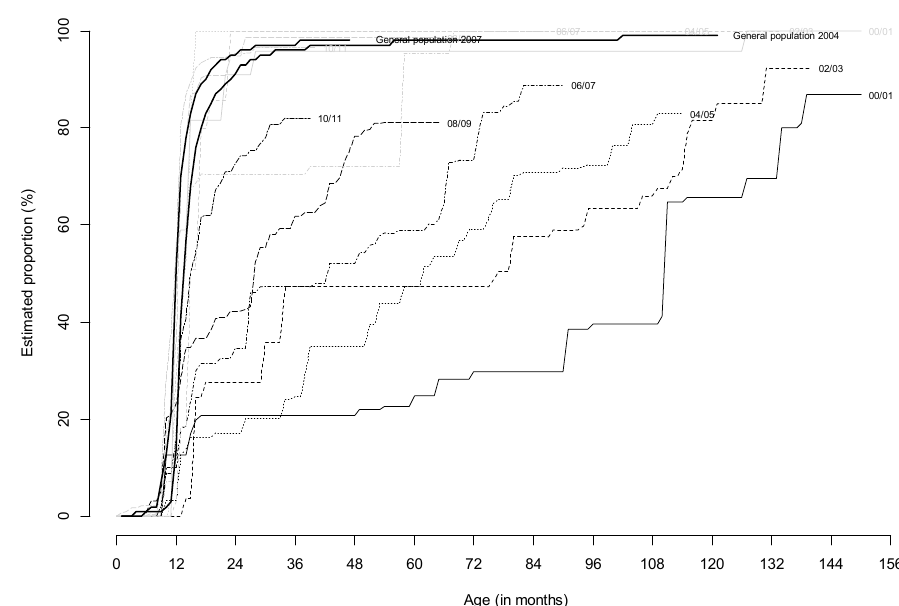
Figure 2. Estimated cumulative proportion of children receiving one dose of MMR according to age (in months) and birthplace in France (gray curves) or outside France (black curves) and according to birth cohort: 2000 / 01 (solid lines), 2002 / 03 (dashed lines), 2004 / 05 (dotted lines), 2006 / 07 (dot-dash lines), 2008 / 09 (long-dash lines), 2010 / 11 (two-dash lines). Note: each point corresponds to the proportion of vaccinated children at a given age.